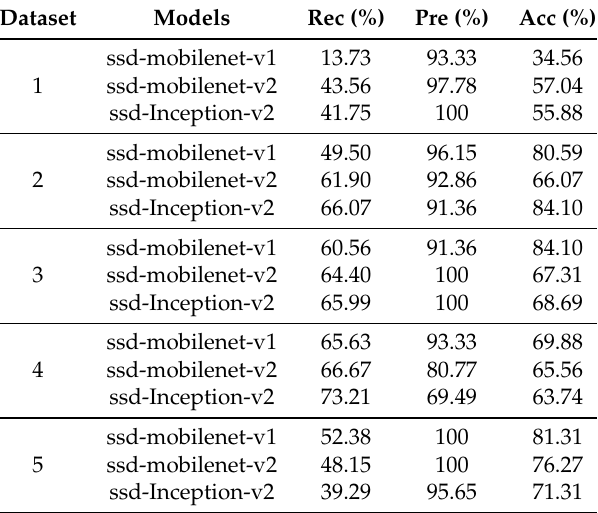
Table 1. Vehicles detection